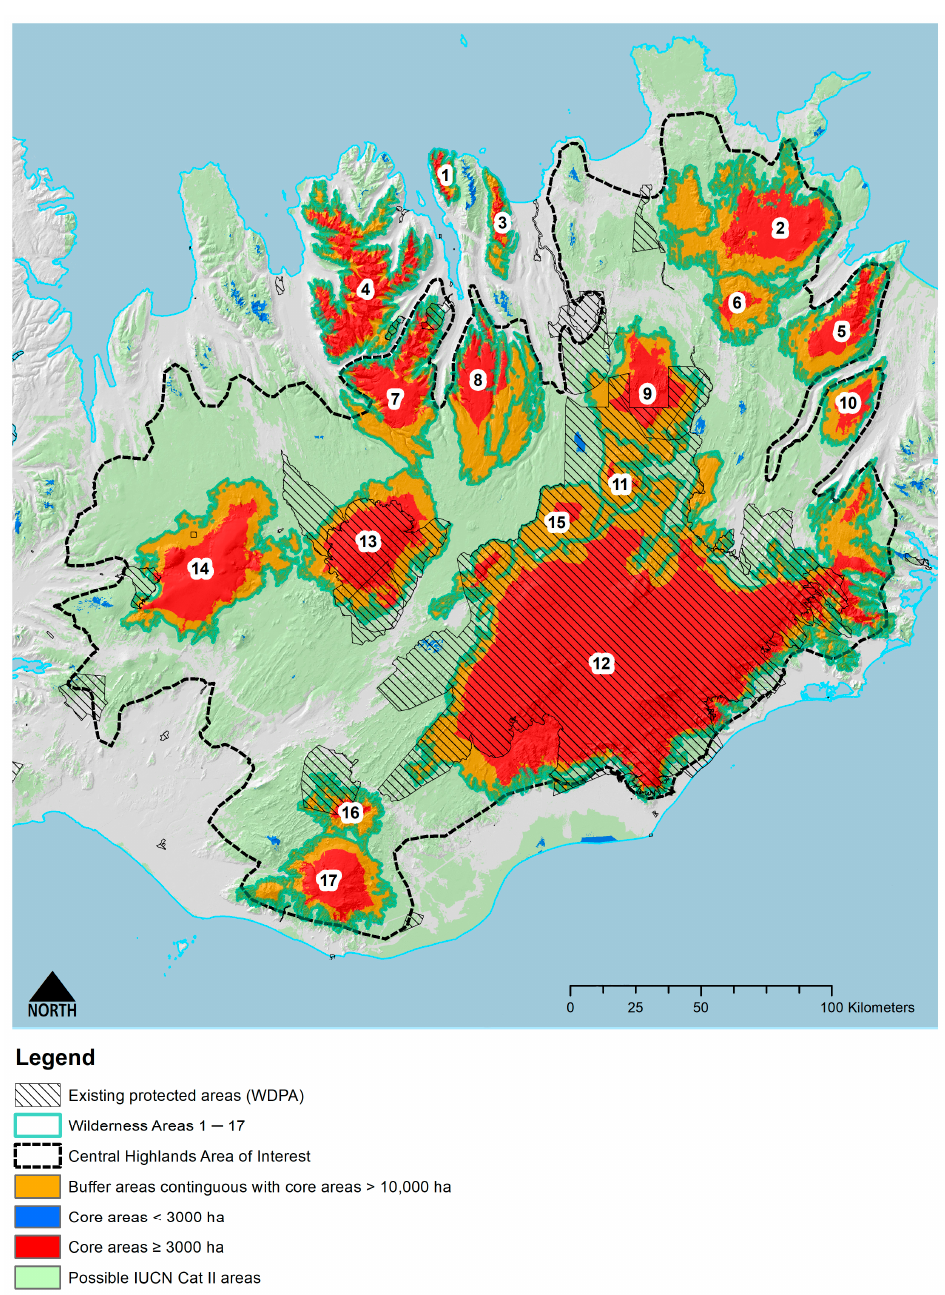
Figure 8. Wilderness areas 1–17 meeting Wild Europe Working Figure 8 . Wilderness areas 1–17 meeting Wild Europe Working Definition .